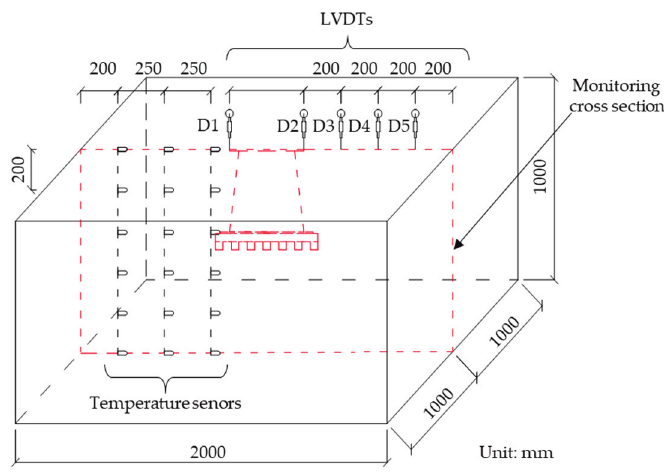
Figure 5. Location of monitoring cross section and the arrangement of electronic